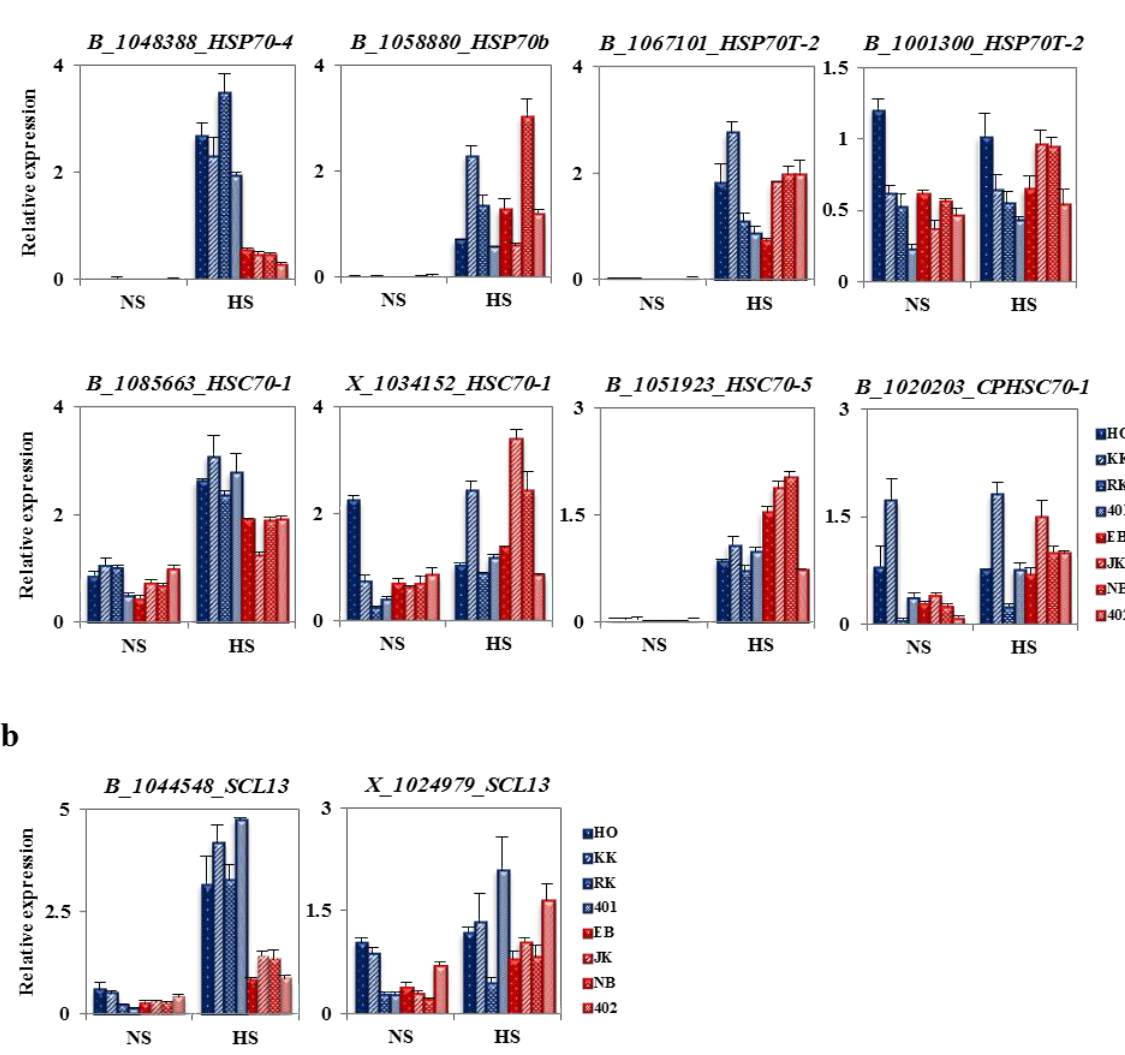
Figure 6. Analysis of fold change in expression of BoHsp70 and BoSCL13 family genes in HTCLs and HSCLs. ( a ) Change in expression levels of different BoHsp70 protein family genes in HTCLs and HSCLs; BoHsp70 , BoHsp70bs , two BoHsp70T-2s , two BoHSC70-1s , BoHSC70-5 and BoCPHSC70-1 ; ( b ) Change in expression of two BoSCL13 genes in HTCLs and HSCLs. HO, KK, RK and 401 are heat-tolerant cabbage inbred lines (HTCLs). EB, JK, NB and 402 are heat-sensitive cabbage inbred lines (HSCLs). Two-week-old plants were heat stress-treated at 42 °C for 4 h (HS) or incubated at 24 °C (NS). Expression levels were normalized to BoActin